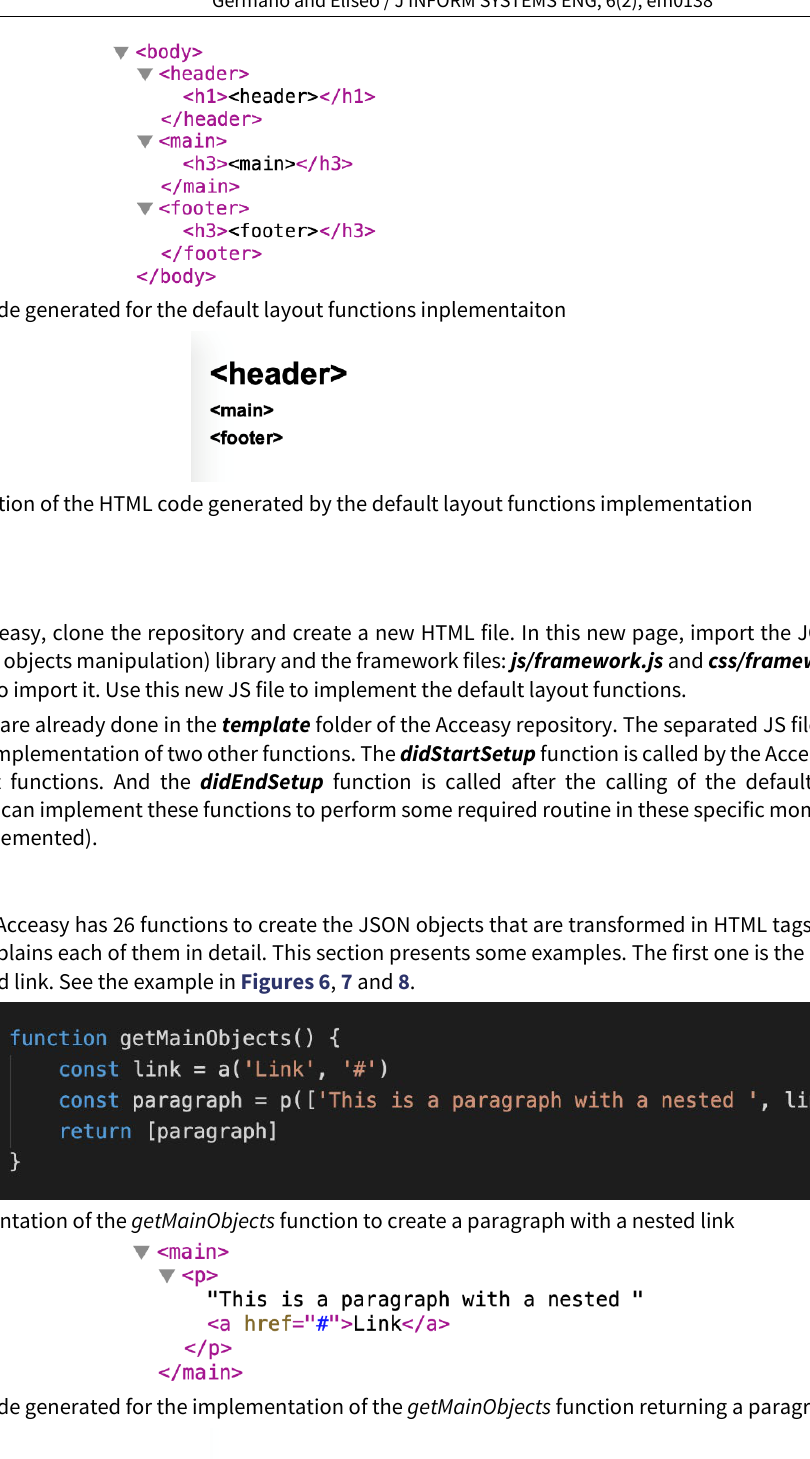
Figure 8. Visualization of the HTML code generated by the getMainObjects function returning a paragraph with a nested link